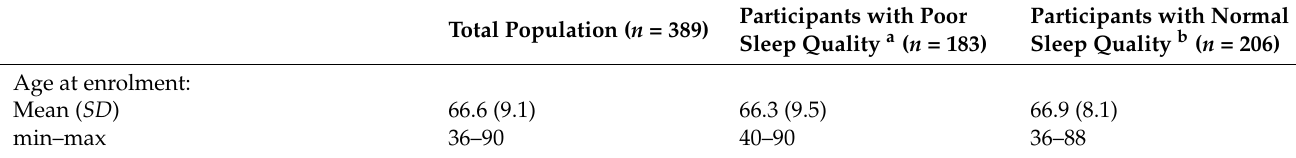
Table 1. Demographic and clinical characteristics of